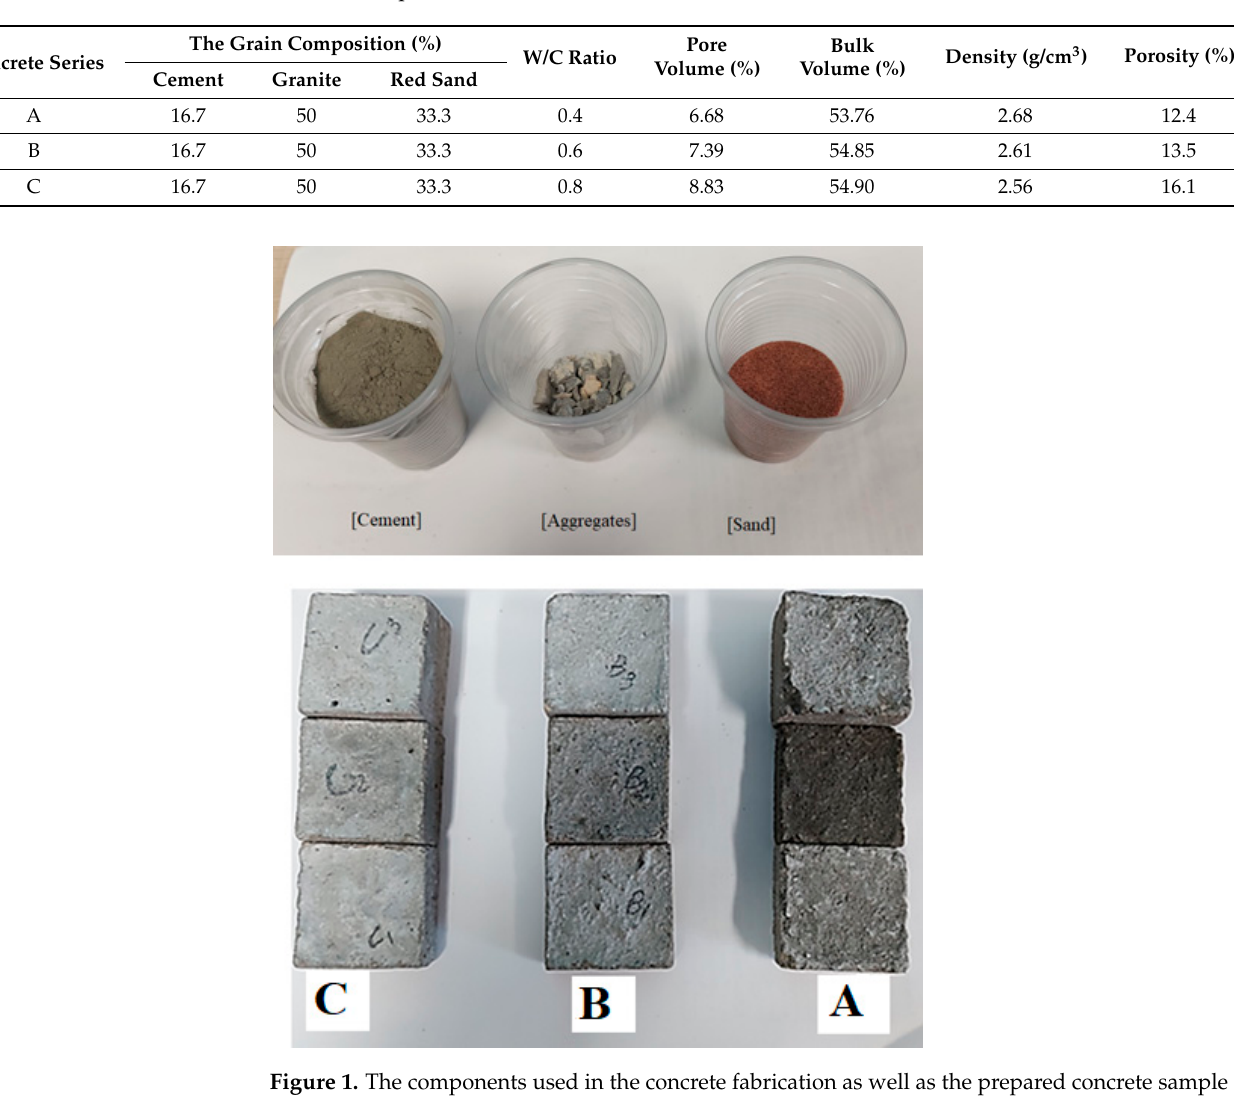
Table 1. The concrete constituent component ratios, density, and porosity of the fabricated concrete samples.